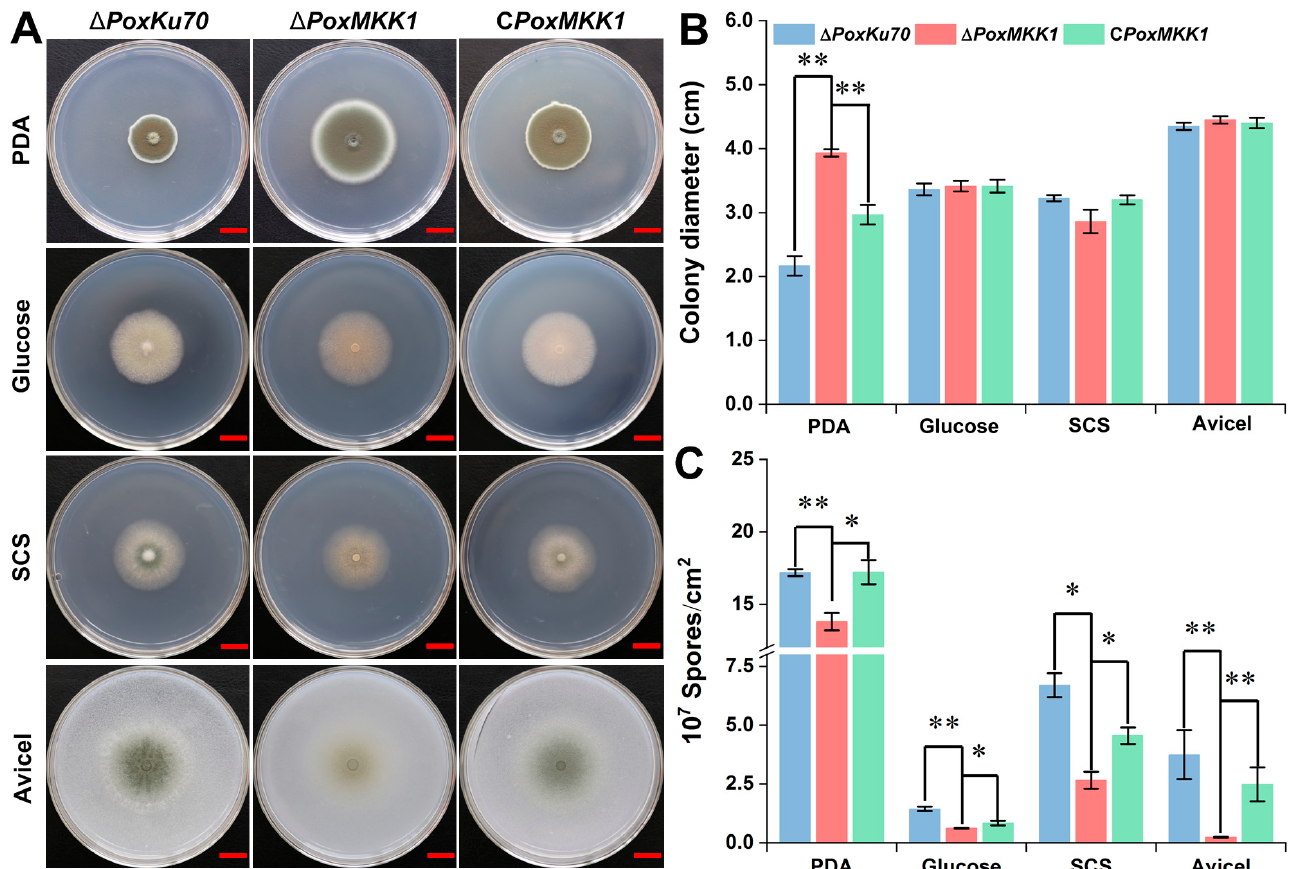
Figure 2. Phenotype characteristics of P. oxalicum mutant Δ PoxMKK1 , the control strain Δ PoxKu70 , and complementary strain C PoxMKK1 on the different solid plates. ( A ) Colony morphology grown for 4 days. Scale bars = 1.0 cm. ( B ) Colony diameter. ( C ) Spore count. The number of spores was counted on PDA at 28 °C for 5 days, on MMM with 1.0% glucose and 1.0% SCS for 14 days, and on 2.0% Avicel for 7 days, respectively. PDA, potato dextrose agarose. MMM, modified minimum medium. SCS, soluble corn starch. The symbols * and ** showed significant differences (* p < 0.05, ** p < 0.01) between mutant Δ PoxMKK1 and the control strain Δ PoxKu70 , and between mutant Δ PoxMKK1 and complementary strain C PoxMKK1 , as assessed by Student’s t -test.